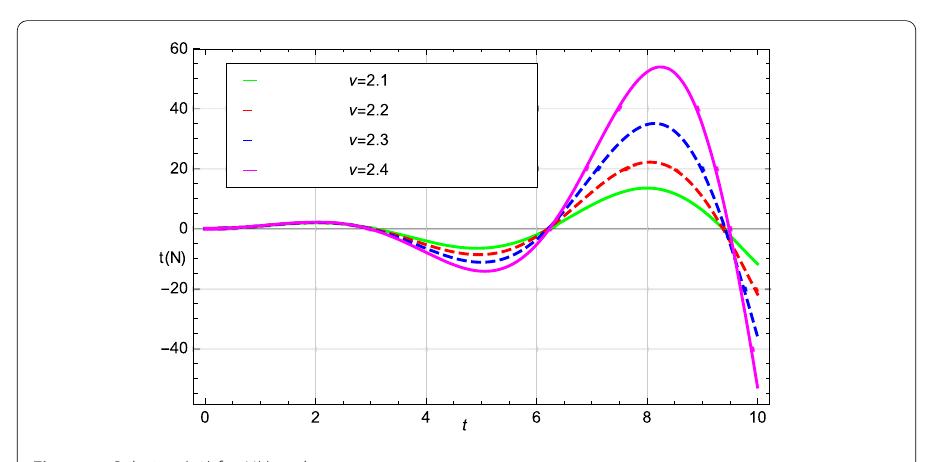
Figure 4 Solution (13) for N ( t ) and t